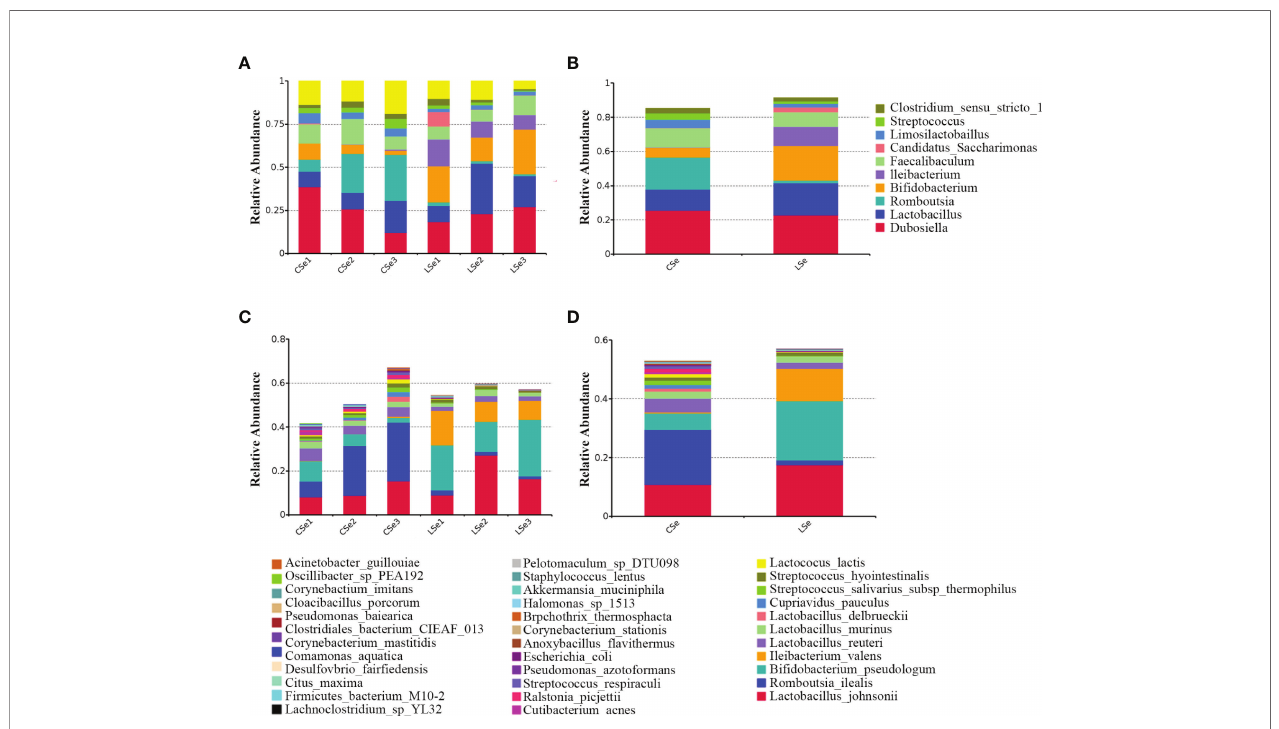
FIGURE 2 | Histogram of relative abundance of species. (A) Histogram of relative abundance of sample species (Top 10, Genus). (B) Histogram of relative abundance of grouped species (Top 10, Genus). (C) Histogram of relative abundance of sample species (Top 35, Species). (D) Histogram of relative abundance of grouped species (Top 35,